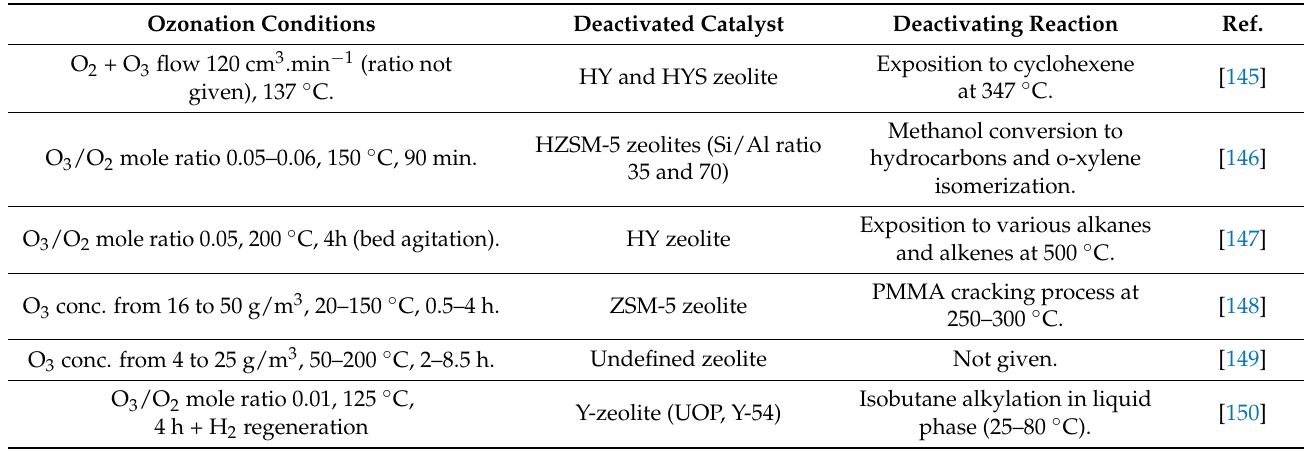
Table 4. Operating conditions for coke removal from coked catalysts using ozone found in literature. Ozonation Conditions Deactivated Catalyst Deactivating Reaction Ref. O 2 + O 3 flow 120 cm 3 .min − 1 (ratio not given), 137 ◦